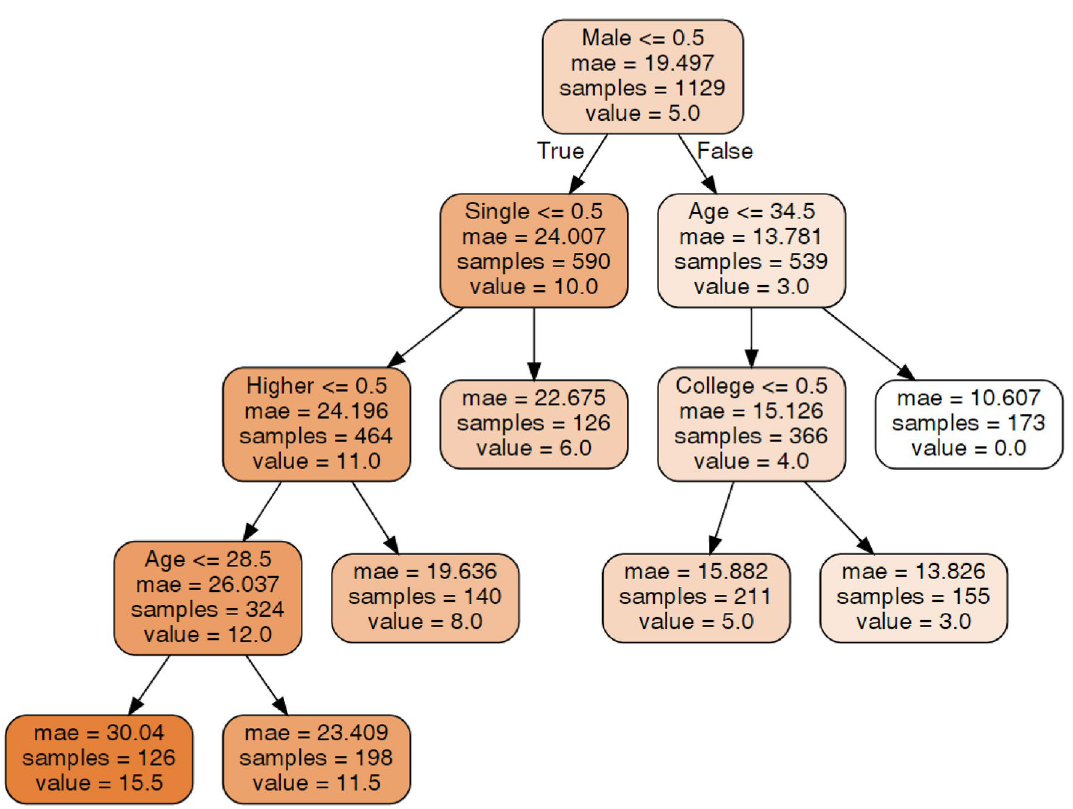
Figure 4. Decision tree for Migraine Disability Assessment (MIDAS). Source: author-generated tree using the sklearn and graphviz